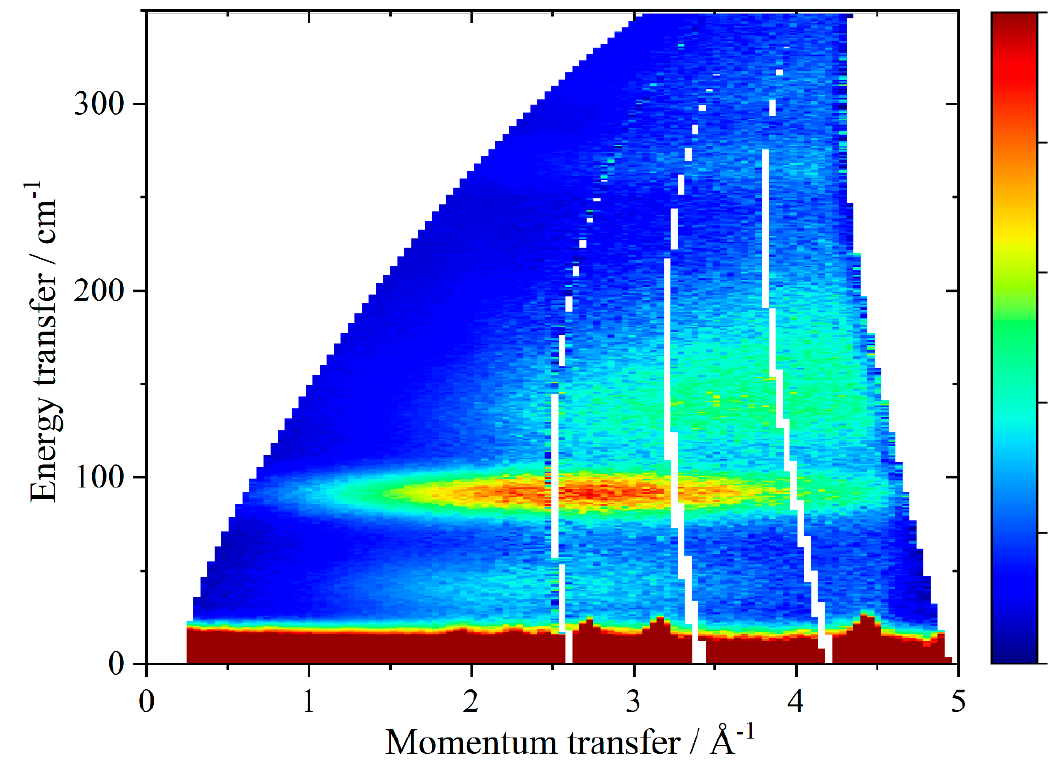
Figure 2. S(Q , ω ) ) map of solid hydrogen deuteride at 7 K with E i = 400 cm − 1 .